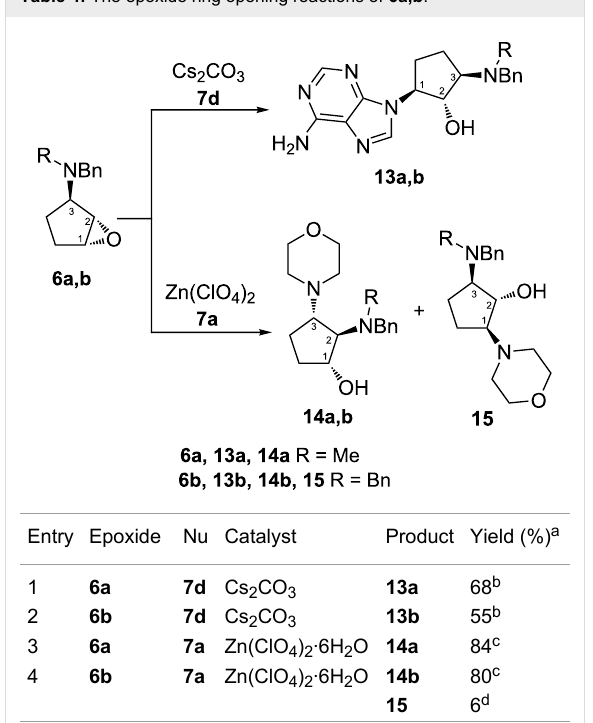
Table 4: The epoxide ring opening reactions of 6a,b